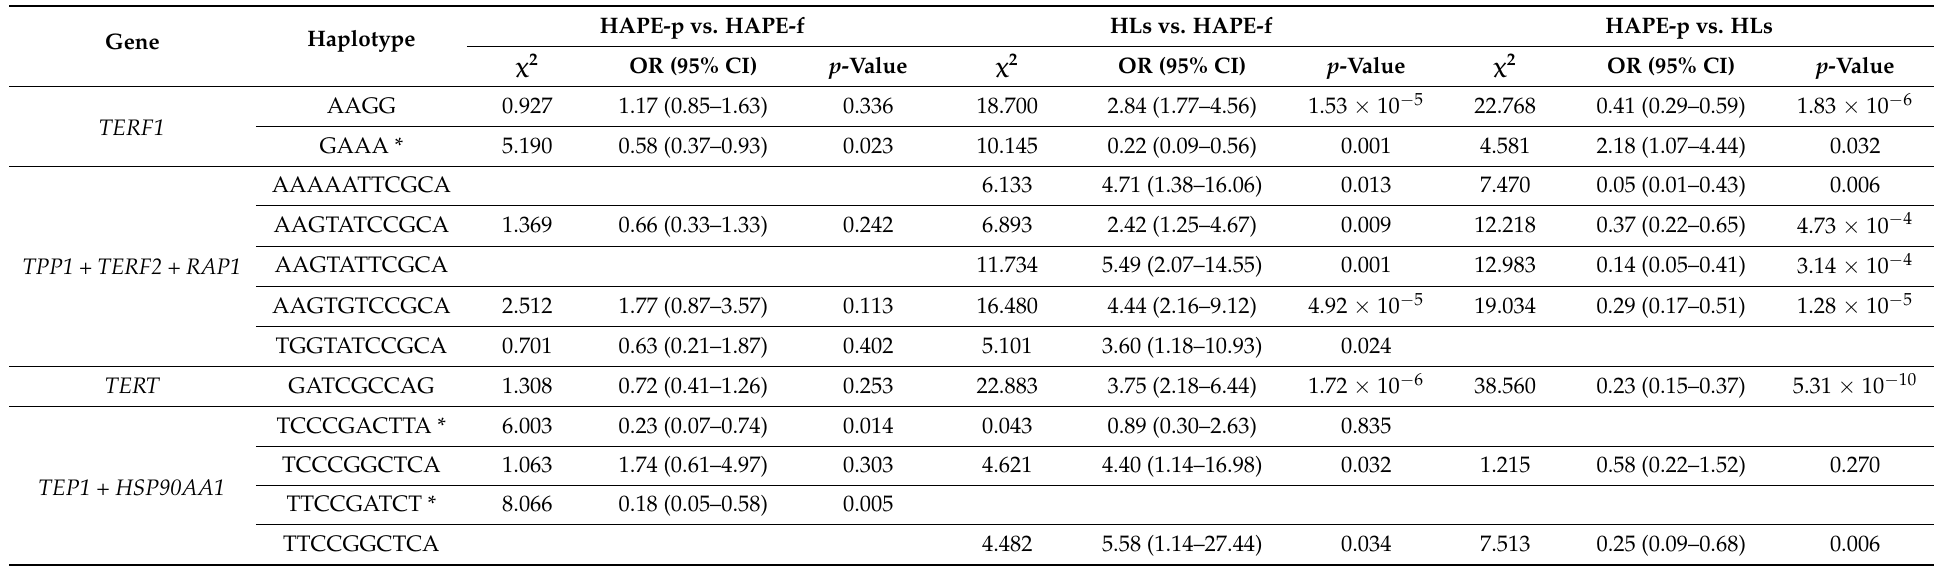
Table 2. Distribution of haplotypes in the three study